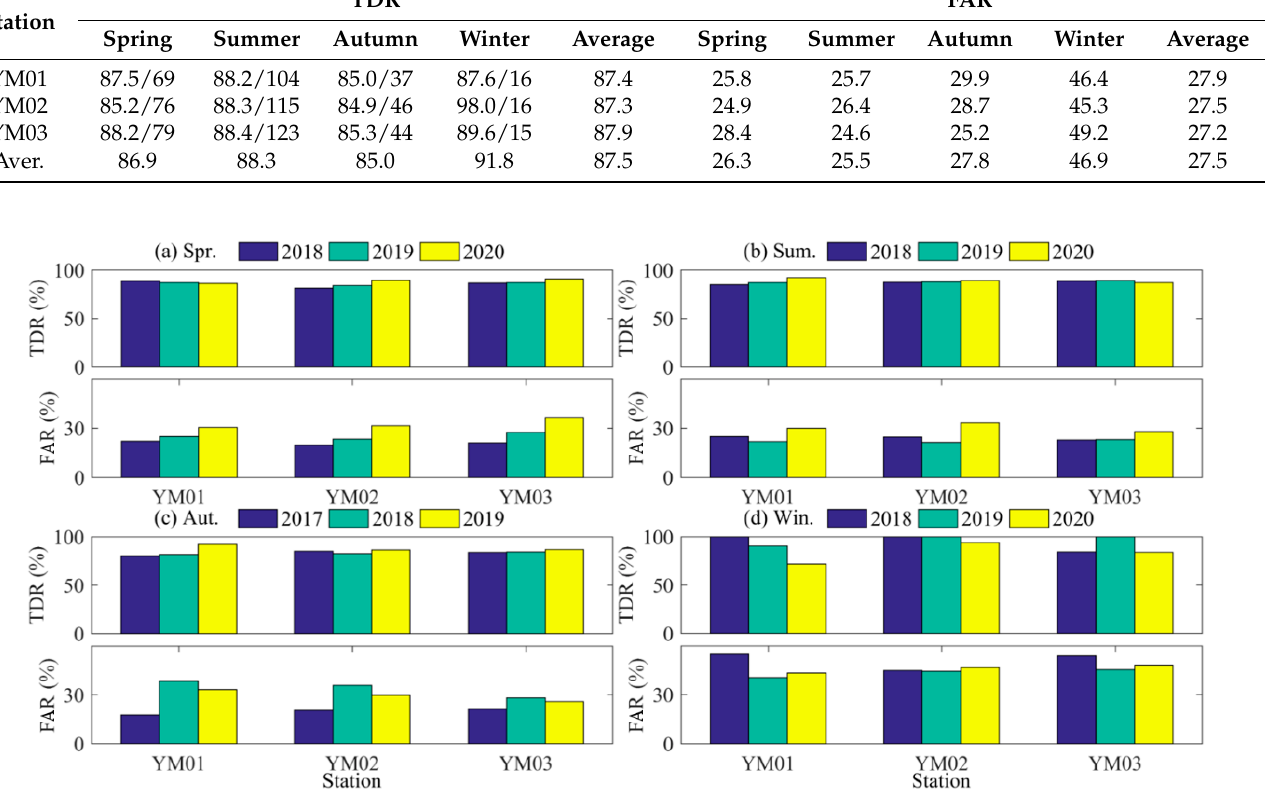
Figure 5. Comparison of TDRs and FARs of the linear method-based rainfall forecast model at three stations in various seasons. Table 2. Statistical results of TDRs and FARs of the linear method-based rainfall forecast model in different seasons at the three stations (%/number of rainfalls).